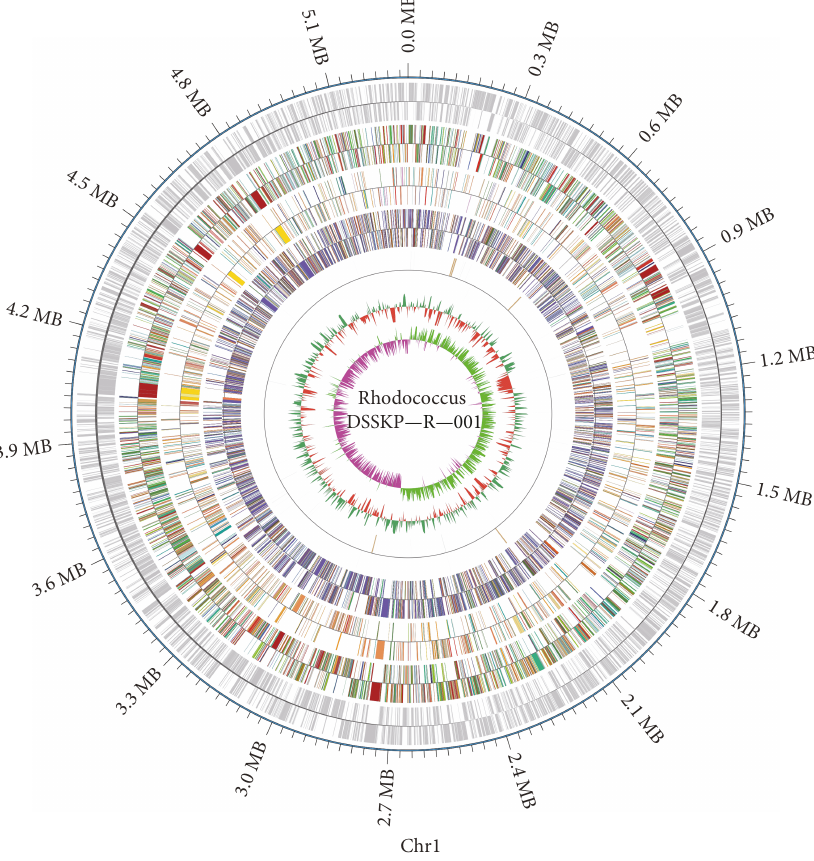
Figure 4: Whole genome map of Rhodococcus strain Rhodococcus sp.